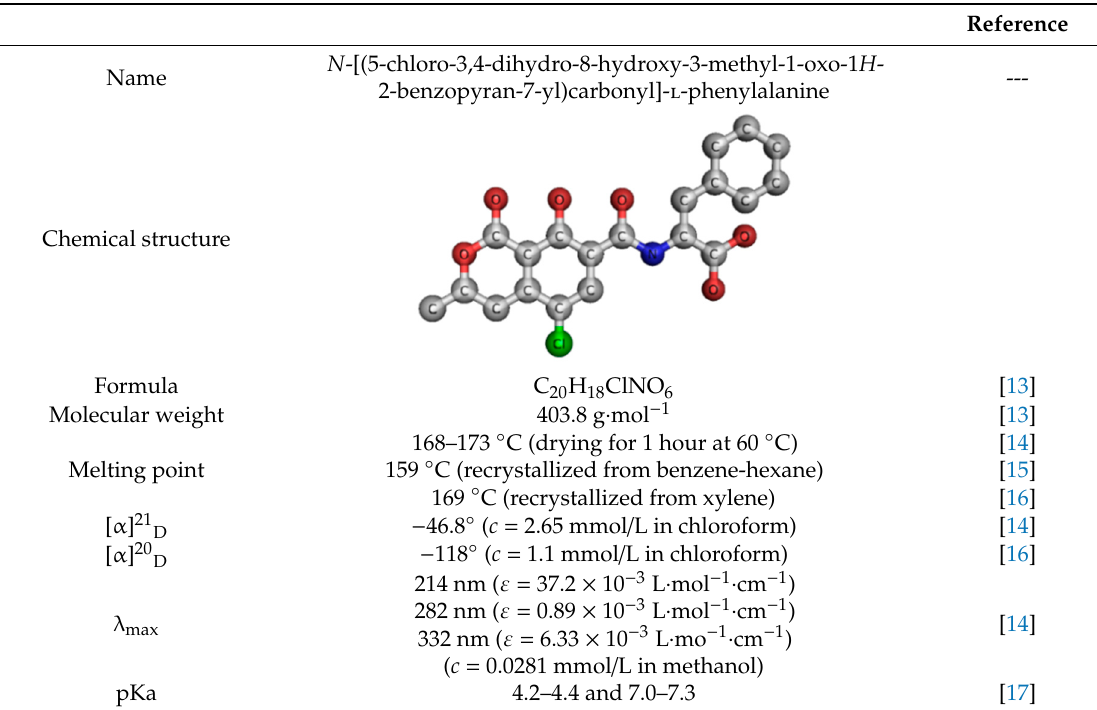
Table 1. Structure, formula and physical characteristics of ochratoxin A (OTA).